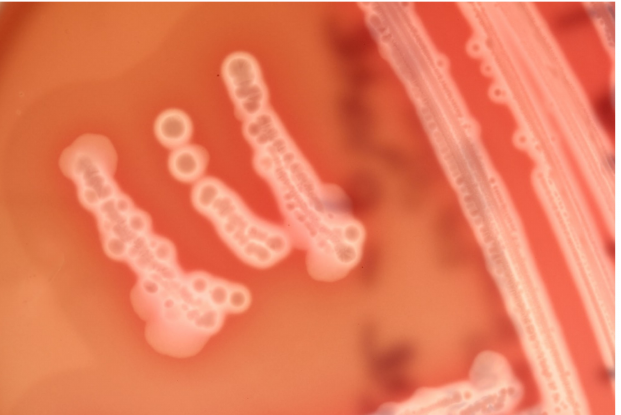
Figure 1. Colonies of Clostridium perfringens on blood agar, surrounded by two halos of hemolysis including an inner, complete zone of hemolysis caused by perfringolysin and an outer zone caused by alpha